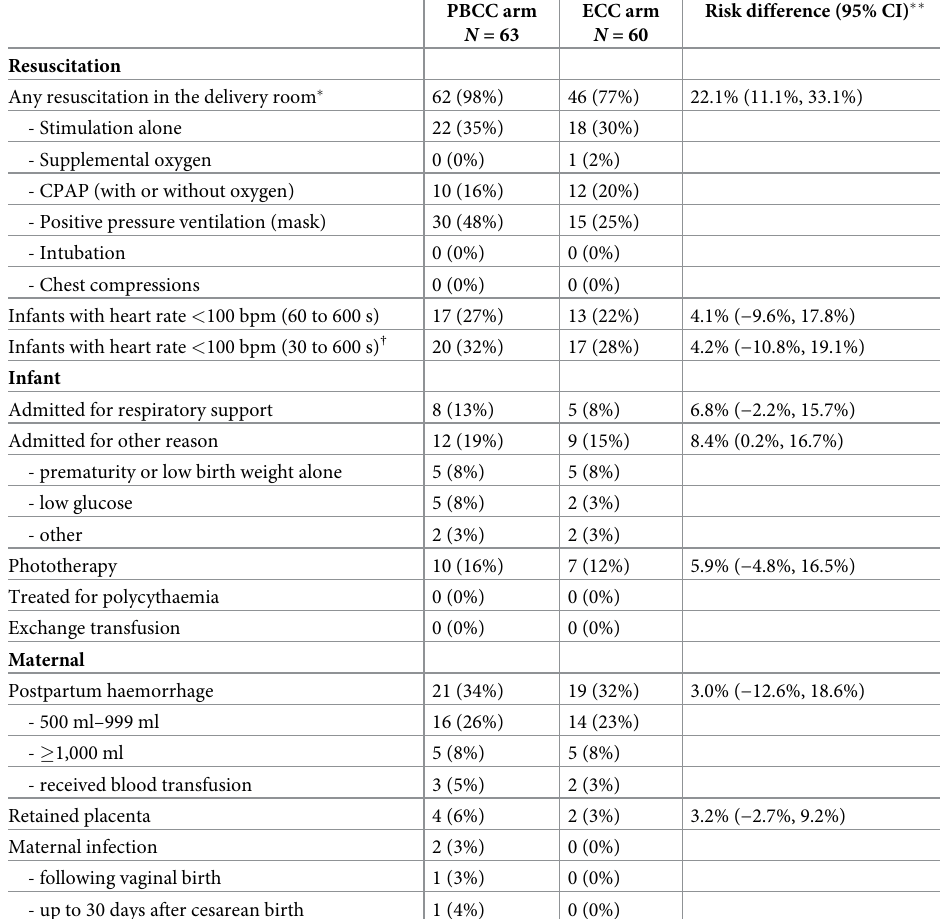
Table 3. Secondary outcomes for categorical